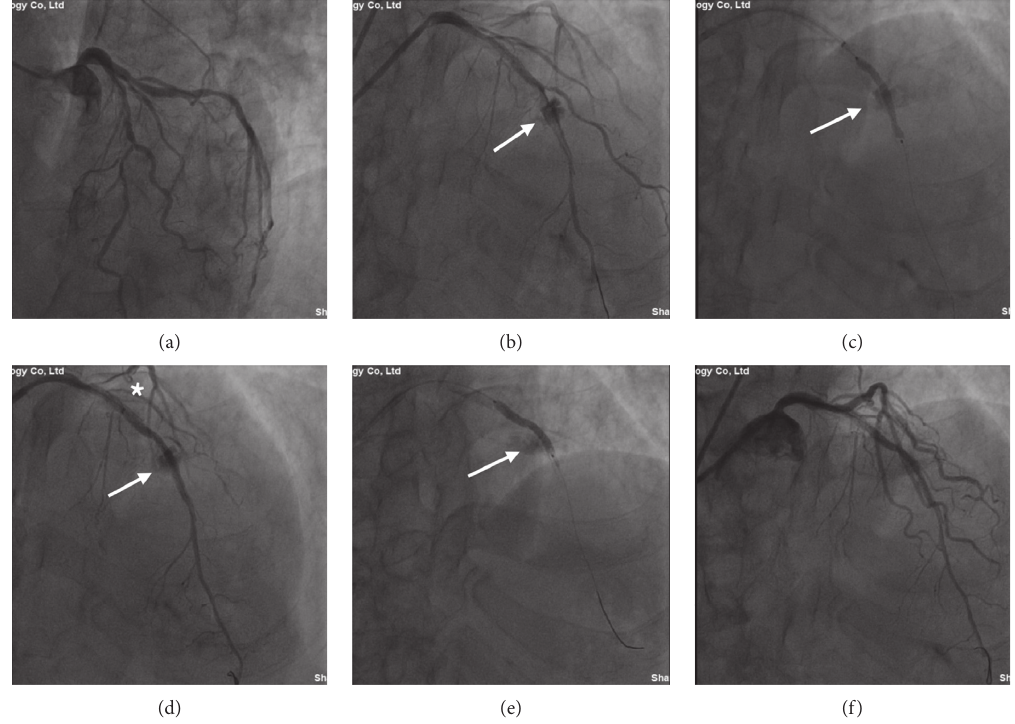
Figure 2: Example of self-made PU-CS implantation to seal a grade III coronary perforation located in LAD. (a) CAG reveals diffuse, tortuous, and calcified lesions in LAD with multiple 80–85% stenotic lesions. (b) CAG demonstrates a coronary artery perforation (Ellis grade III) in LAD (arrow). (c) CAG illustrates the deployment of the first self-made PU-CS (3.0 × 29mm) in LAD (arrow). (d) CAG shows that the perforation site in LAD persists (arrow) and Guidezilla was used to deliver CS ( ∗ ). (e) CAG presents the deployment of the second self-made PU-CS (3.0 × 29mm) (arrow). (f) Final angiography after successful implantation of CS. PU-CS � polyurethane-covered stent; LAD � left anterior descending coronary artery; CAG � coronary